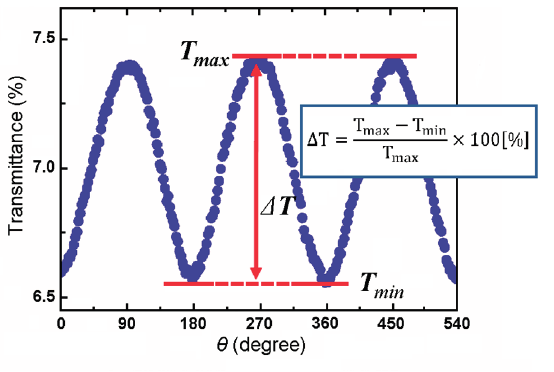
Figure 15. Time dependence of the transmitted light through the particle solution in a rotating magnetic field with frequency 0.1 Hz. Adapted from [12].